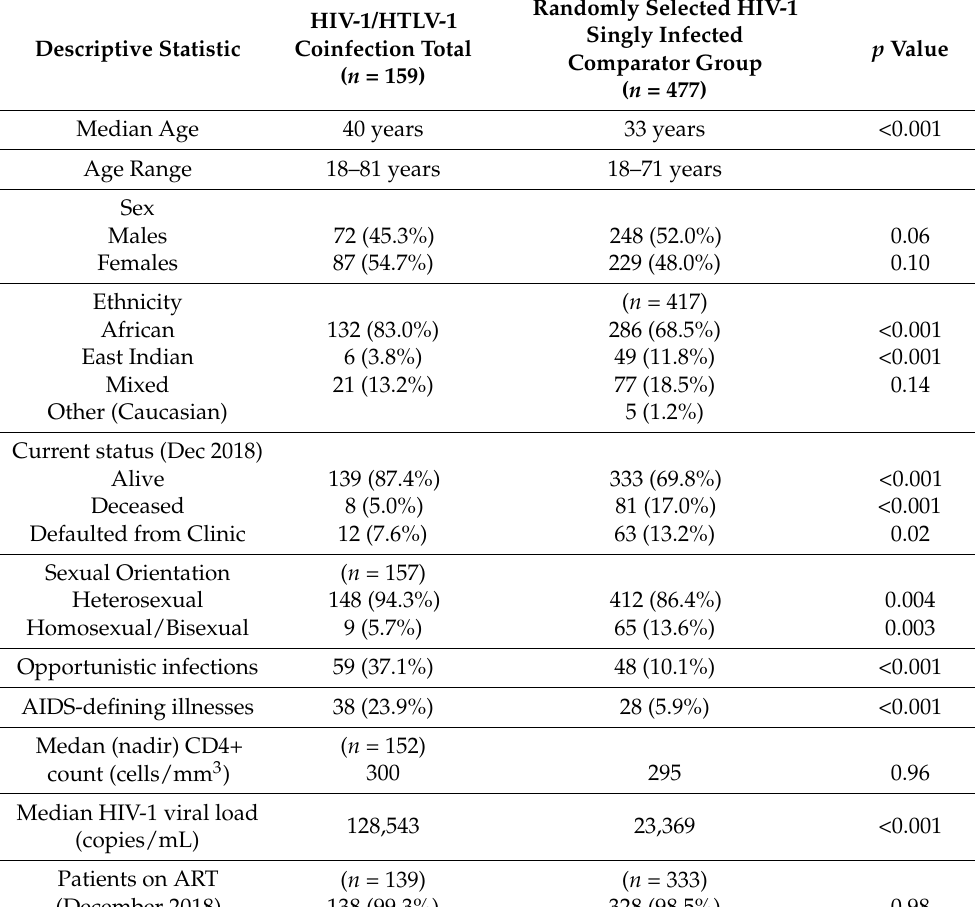
Table 1. Baseline characteristics of the study population at initial visit